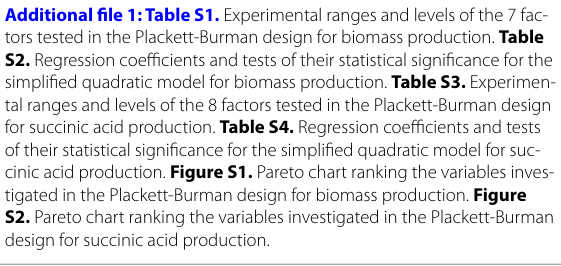
Additional file 1: Table S1. Experimental ranges and levels of the 7 fac‑ tors tested in the Plackett‑Burman design for biomass production. Table S2. Regression coefficients and tests of their statistical significance for the simplified quadratic model for biomass production. Table S3. Experimen‑ tal ranges and levels of the 8 factors tested in the Plackett‑Burman design for succinic acid production. Table S4. Regression coefficients and tests of their statistical significance for the simplified quadratic model for suc‑ cinic acid production. Figure S1. Pareto chart ranking the variables inves‑ tigated in the Plackett‑Burman design for biomass production. Figure S2. Pareto chart ranking the variables investigated in the Plackett‑Burman design for succinic acid